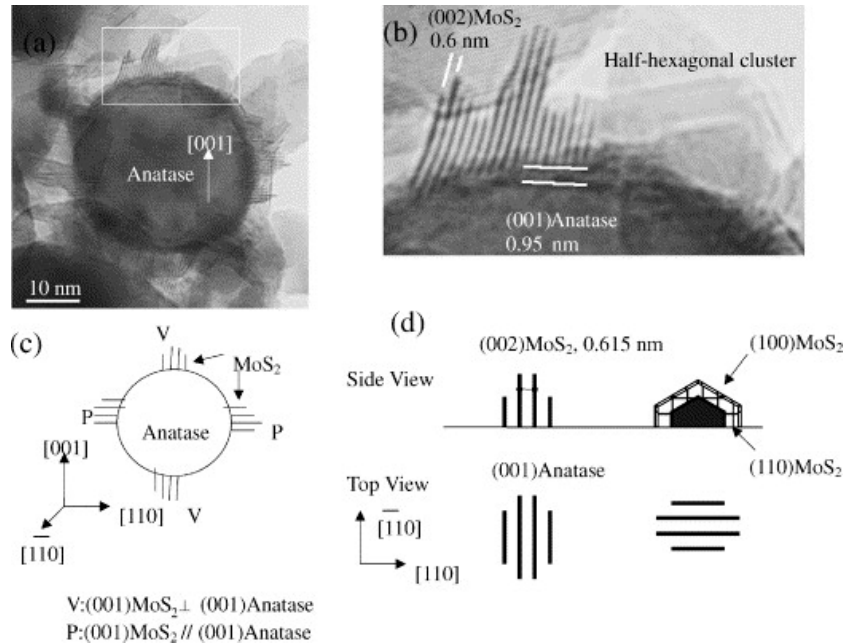
Figure 3. ( a , b ) TEM micrographs and ( c , d ) schematic diagrams of MoS 2 clusters supported on TiO 2 anatase powders. Sakashita et al. [29].